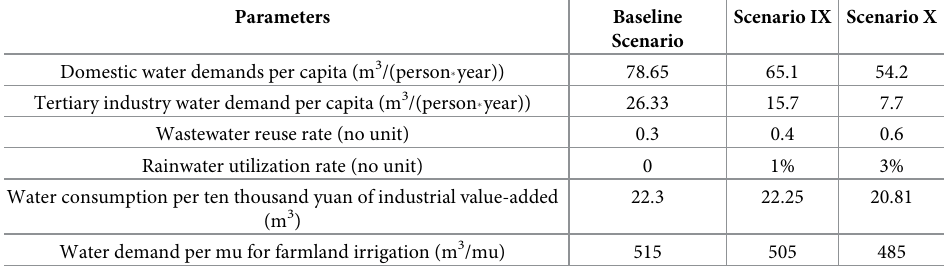
Table 5. Integrated optimization scenarios.